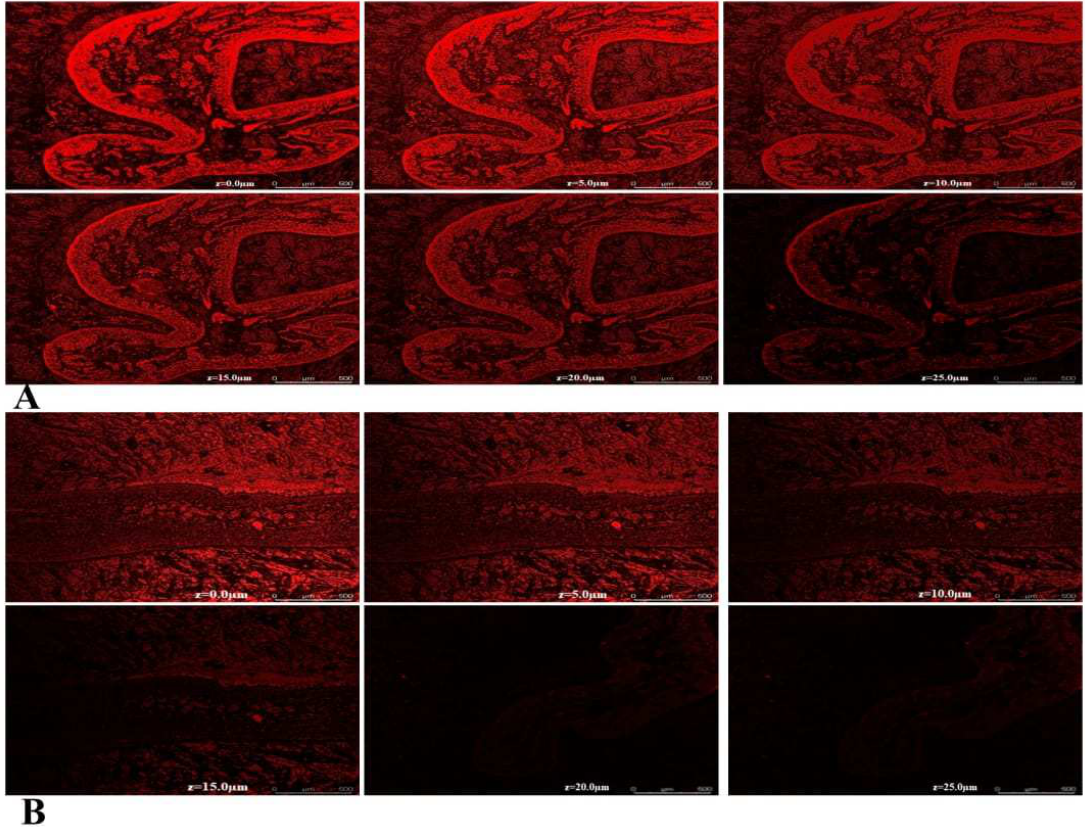
Figure 9. Image of CLSM for intestinal tissues treated with AZL-NE ( A ) and drug suspension ( B ).